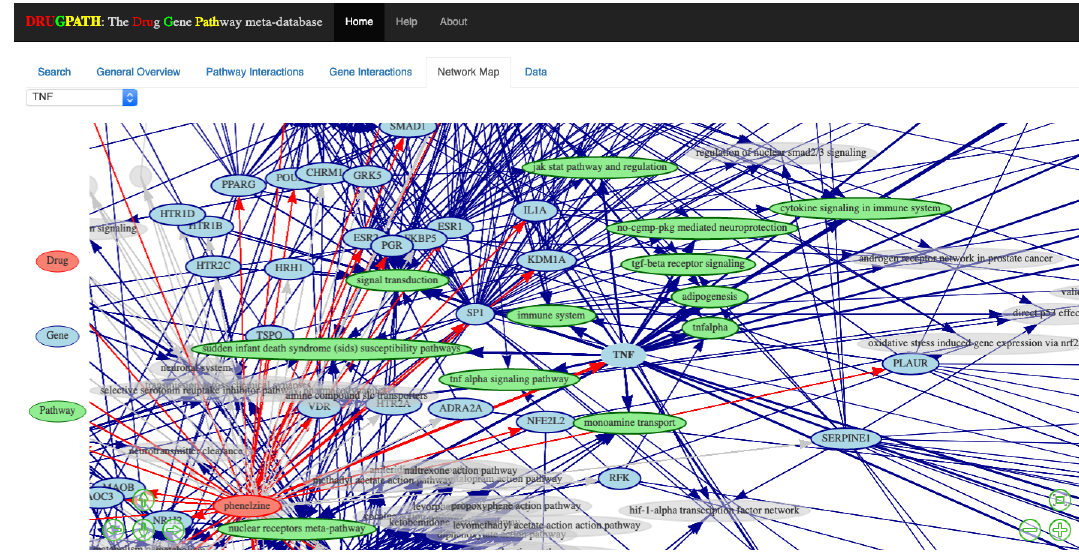
Figure 5. Closer examination of all drugs and pathways associated with the gene TNF . Any drug, gene, or pathway not associated with this gene are greyed out and made